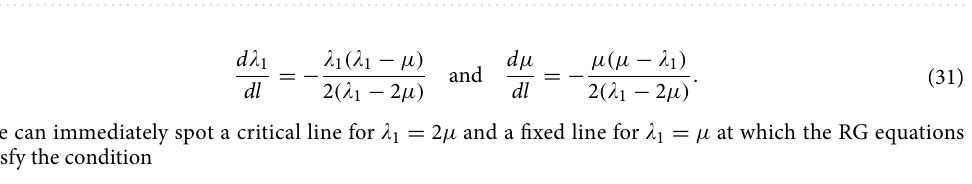
Figure 10. RG flow lines on the critical line (cid:31) 2 and towards the line (cid:31) 1